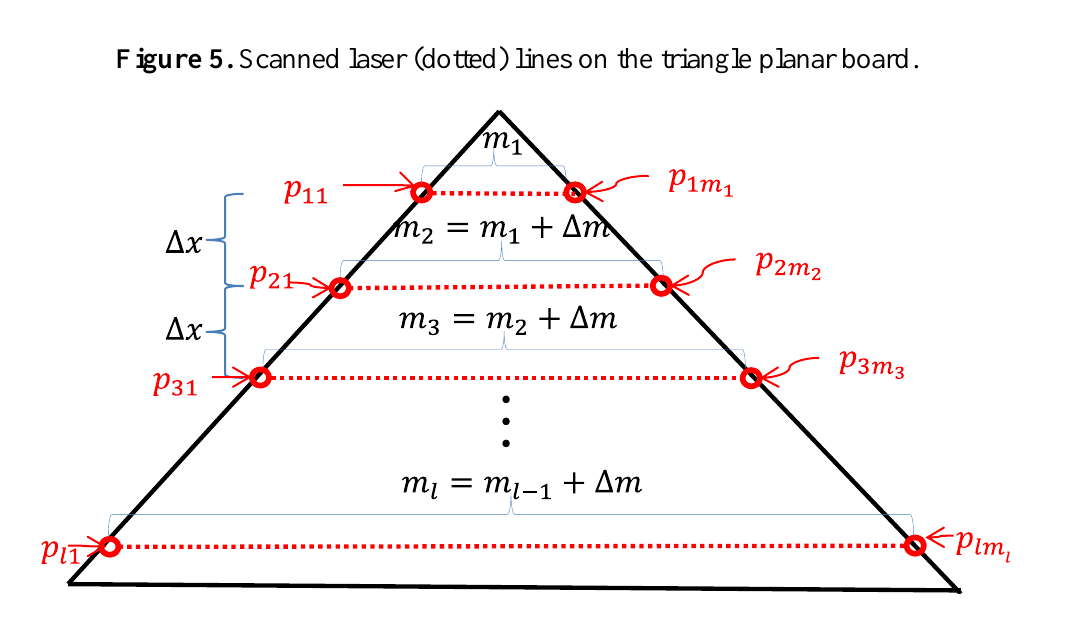
Figure 6. The 3D points (red) and its orthogonal projection (green). The inlier 3D points of the RANSAC are selected by: ( a ) inlier ratio ; ( b ) inlier line ratio